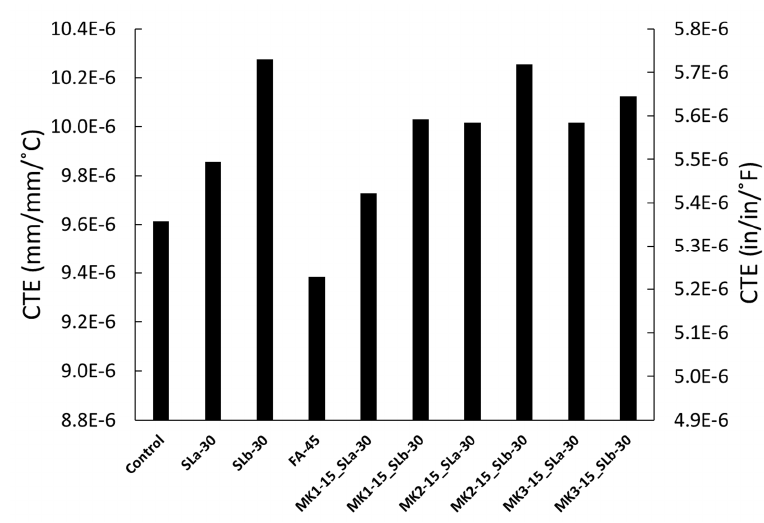
Figure 9. CTEs of binary benchmark and ternary SCM mixtures.